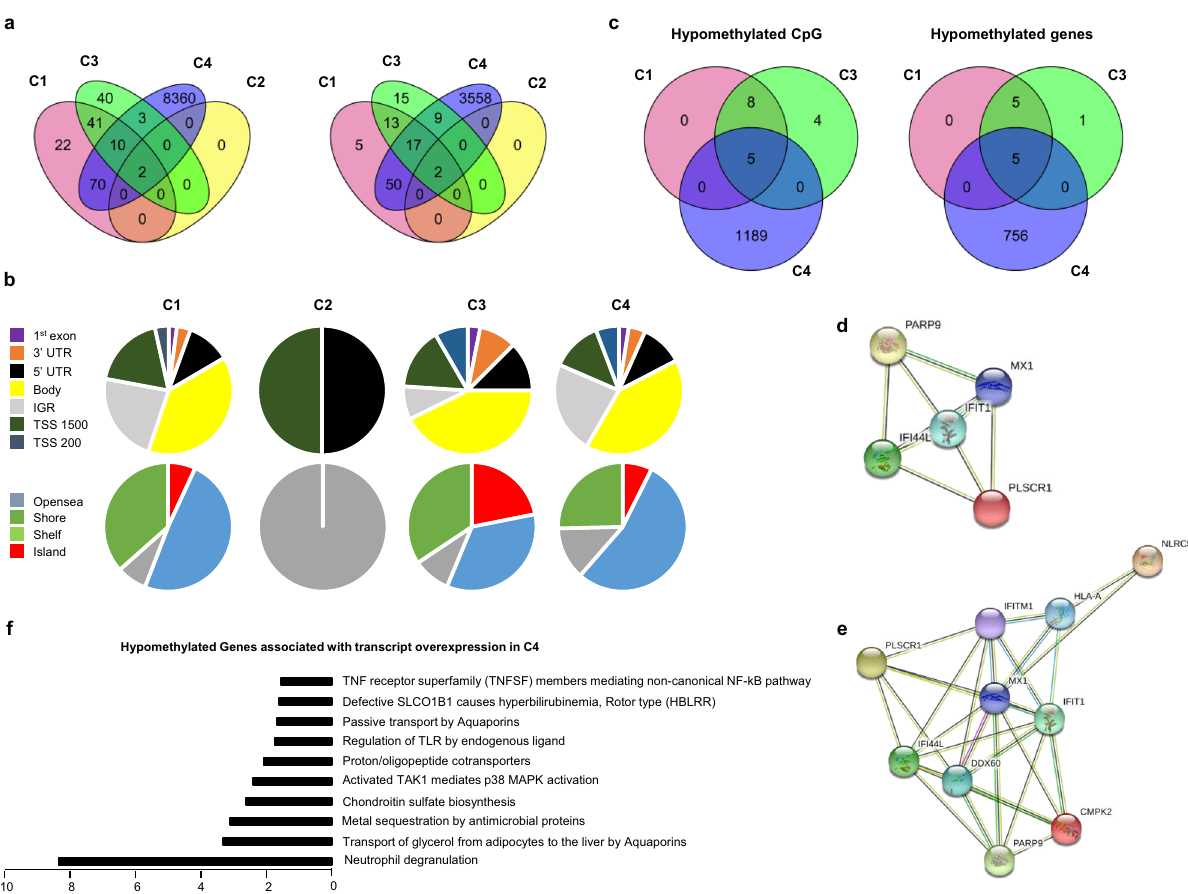
Fig. 5 Methylation analysis con fi rms the strong IFN signature in C1 and C3 and reveals an aberrant methylation status in C4. Whole blood methylation analysis was performed for 226 pSS patients (C1: 81, C2: 57, C3: 62, and C4: 26) and 175 healthy volunteers (HV) doing pairwise comparisons between each cluster and HV. a Venn diagram showing the overlap of differentially methylated CpG sites and genes between the 4 clusters with absolute Δ Beta > 0.075. b DMP distribution across the different genomic regions (gene body, 3 ’ UTR, intergenic (IGR), 5 ’ UTR, Exon 1, TSS 1500 and TSS 200; and according to the CpG density to CpG island, shelf, shore, and open sea. c Venn diagram showing the overlap of hypomethylated CpG and genes with absolute Δ Beta > 0.15 between the three IFN clusters. d Interaction network of these 5 genes common to the three clusters by STRING analysis with a con fi dence cut-off of 0.4 reveals a common IFN signature. e Interaction network of the 10 genes hypomethylated common to C1 and C3 by STRING analysis with a con fi dence cut-off of 0.4. f Reactome analysis 22 of the functional pathways enriched for the 126 genes hypomethylated and over expressed in C4 (absolute Δ Beta > 0.15, FC ≥